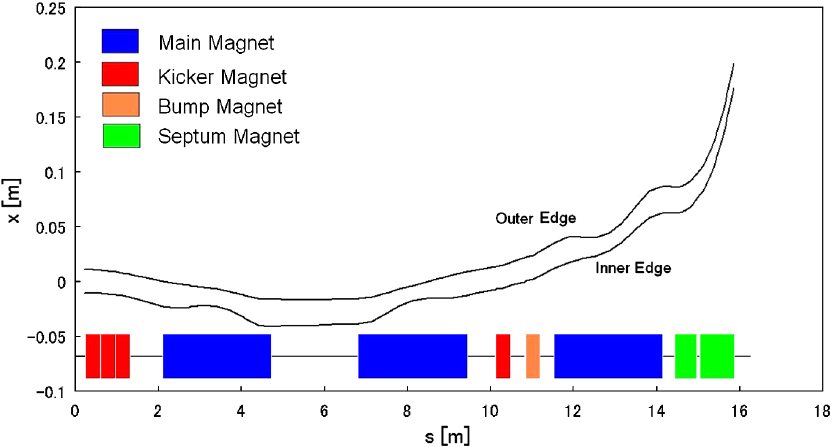
FIG. 22. Extraction system and the beam envelope.